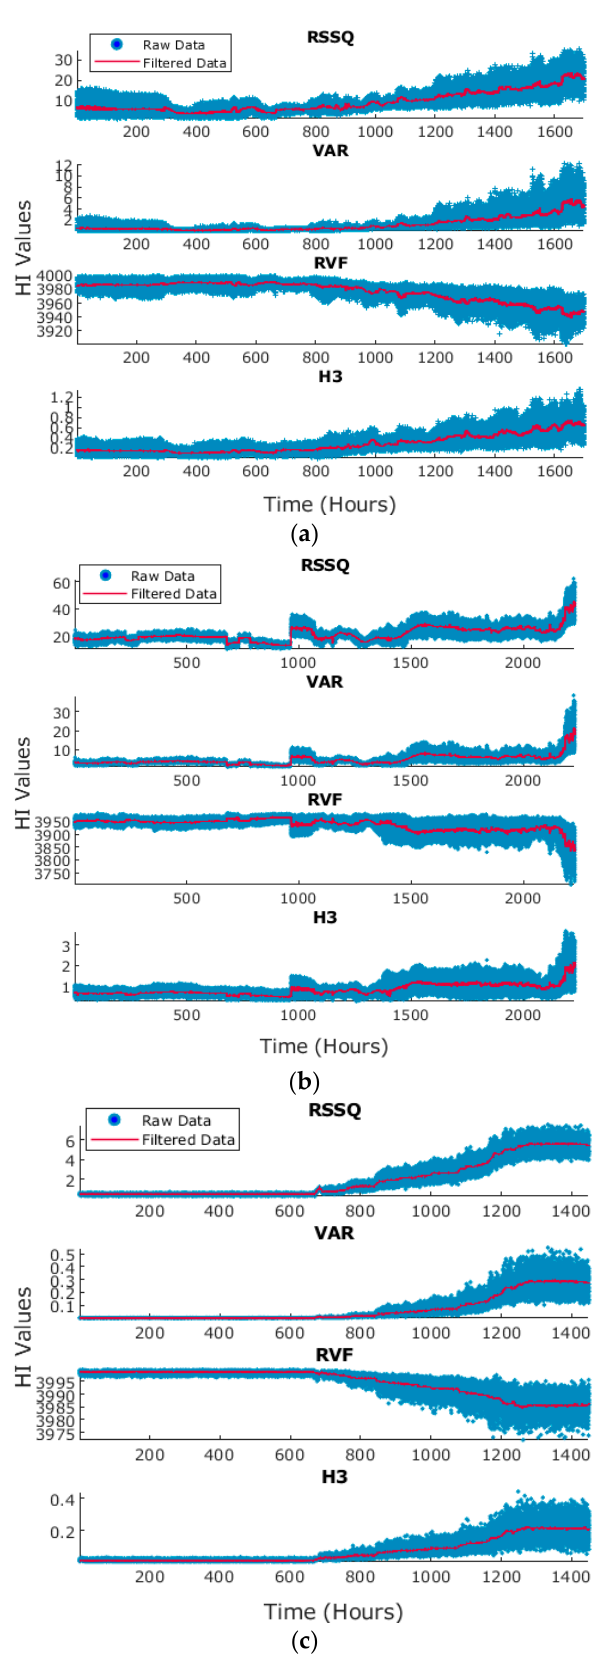
Figure 11. Feature trends for different faults. ( a ) Inter-turn short circuit fault. ( b ) Winding short- circuit fault, ( c ) Hybrid fault.